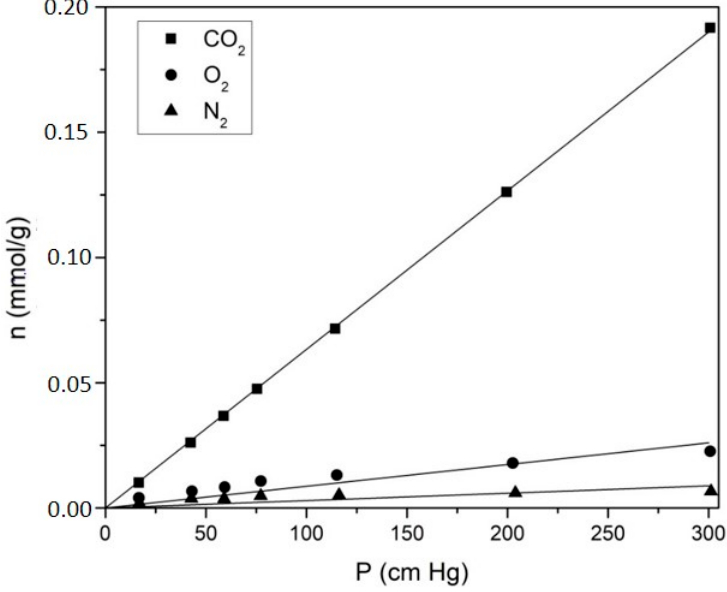
Figure 9. N 2 , O 2 , and CO 2 sorption isotherms obtained by the barometric method for the PU10-1